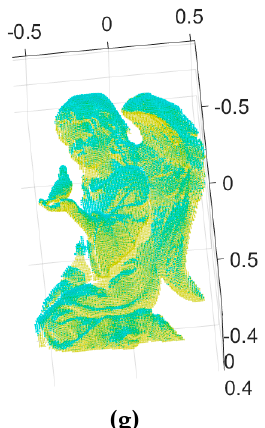
Figure 6. 3D registration results for the proposed method and others: ( a , b ) two input synthetic range images with no noise, ( c – e ) range images aligned by Go-ICP, trimmed Go-ICP, and fast global registration, respectively, ( f ) range images aligned by our branch-and-bound, ( g ) the refined registration result of ( f ) by ICP.